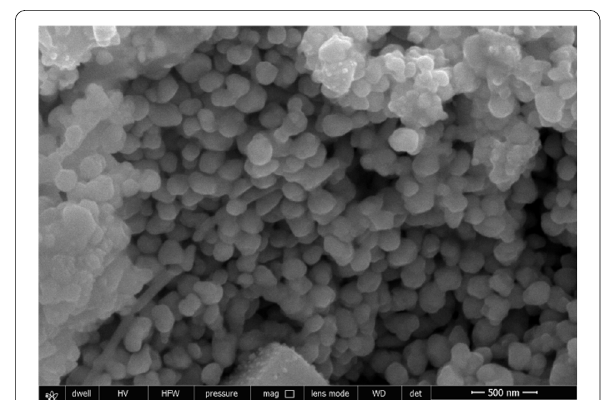
Fig. 6 FESEM image of